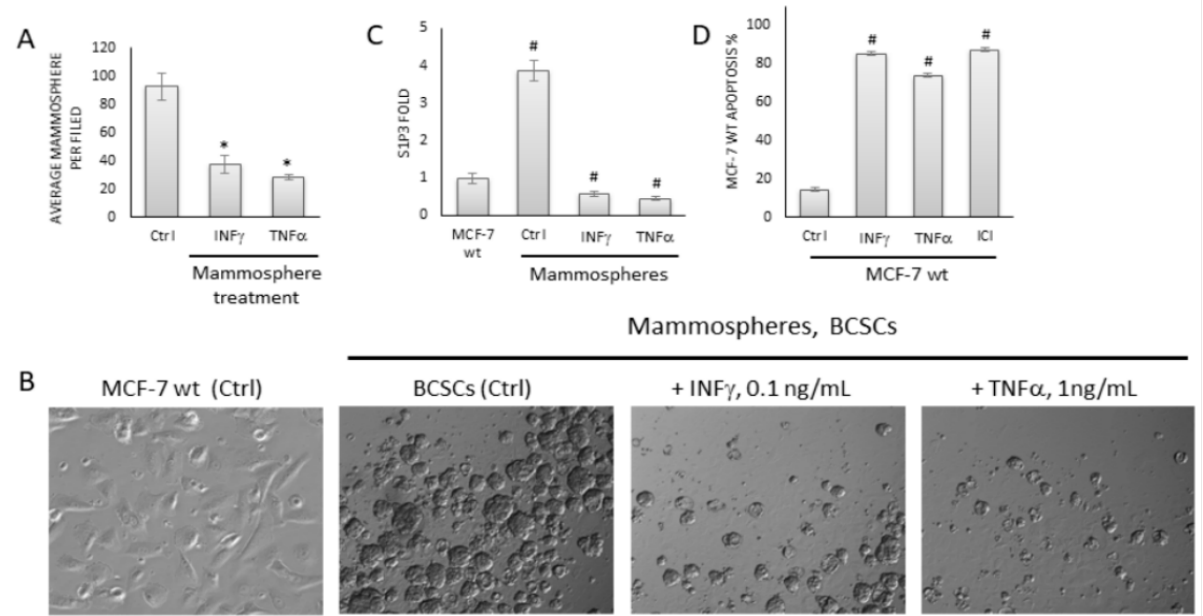
Figure 2. Biological effects of TNF α on parental MCF-7 cells and MCF-7-derived, BCSC-enriched mammospheres. ( A ). TNF α and INF γ treatments led to significant reduction in mammosphere growth. Representative images are shown ( × 20); experiments were repeated at least 4 times with similar results. ( B ). MCF-7 cells (Ctrl; controls) are shown as an example of parental cells line phenotype. Mammospheres were treated with TNF α and INF γ and photographed. Representative images are shown. ( C ) Rt-PCR analysis of S1P3 expression in parental and MCF-7-derived mammospheres. The level of housekeeping gene β -actin was used to estimate fold change in S1P3 expression. ( D ) INF γ (0.1 ng/mL), TNF α (1 ng/mL), and ICI182780 (ICI; 10 nM) stimulated apoptosis in MCF-7 wild-type (parental) cells after 72 h treatment. Flow cytometry was used to estimate apoptosis % of PI and Annexin V positive cells. * p -value < 0.05; # p -value <